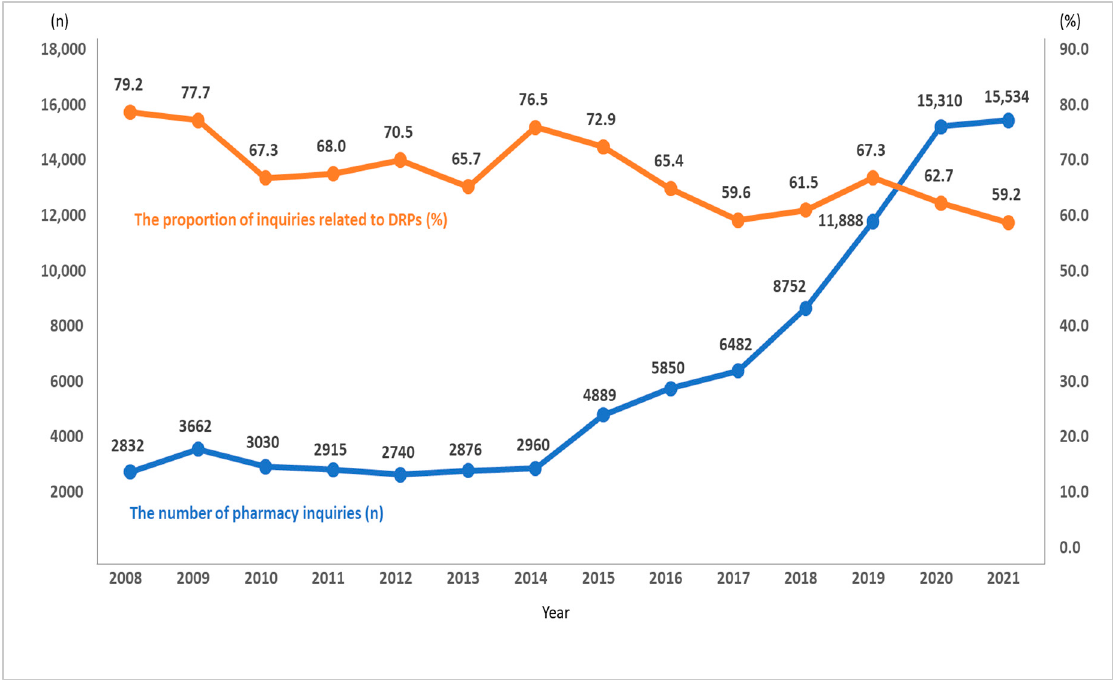
Figure 3. The number of pharmacy inquiries (blue line, n ) and the proportion of inquiries related to DRPs (orange line, %). DRPs: drug-related problems.